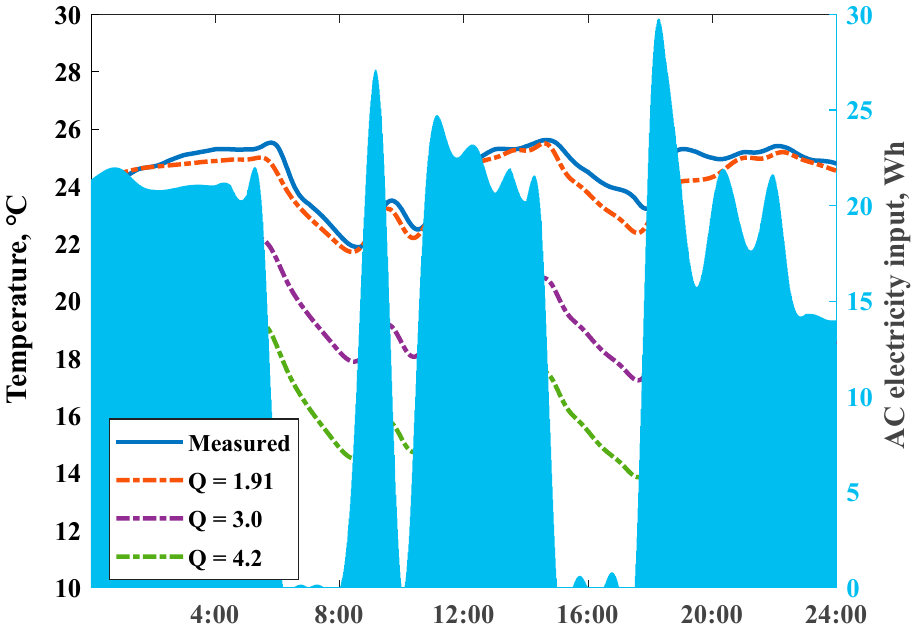
Figure 10. Scenario of measured and simulated indoor air temperatures with unchanged AC heating power input under different Q values.